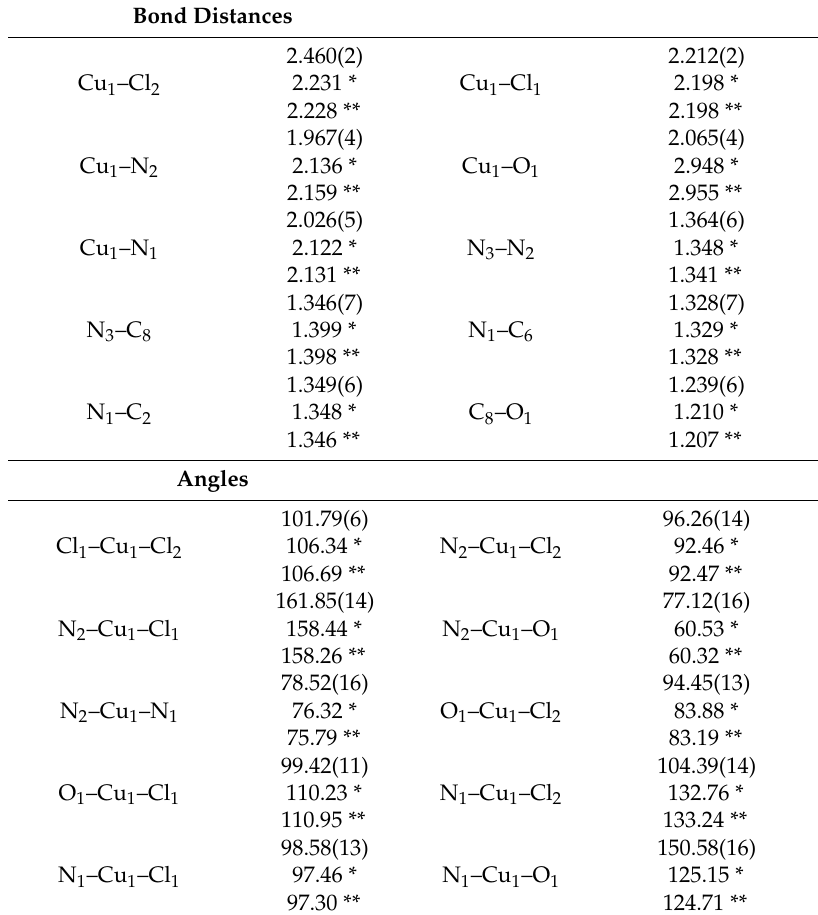
Figure 6. Thermal ellipsoid plot for the two possible disorder orientations in the adamantyl moiety ( a ) and ( b ) of 1 , drawn at the 30% probability level, with atomic labeling and numbering schemes. The crystalline solvent (CHCl 3 ) and the hydrogen atoms on adamantyl have been omitted for clarity. In the complex, N 1 , N 2 , O 1 and Cl 1 occupy the basal plane of a distorted square pyramid, where the Cl 2 is located in the apical position. The bond distances and bond angles of compound 1 are listed in Table 3. Table 3. Selected bond lengths (Å) and angles [ ◦ ] for 1